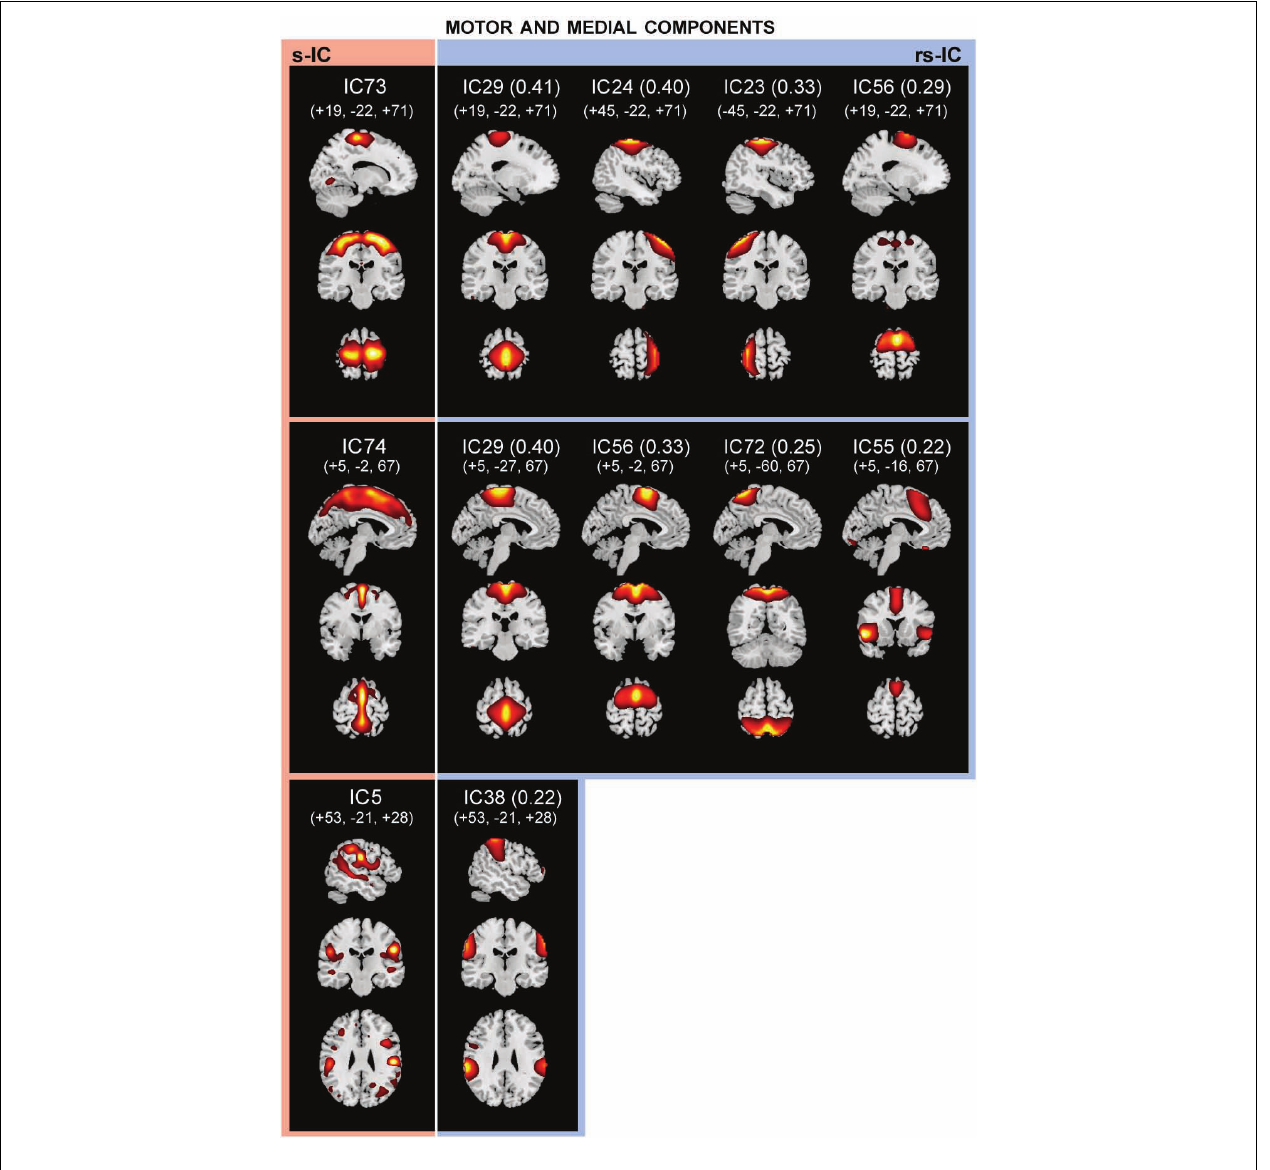
peak activation, indicated as ( x , y , z ) coordinates in MNI space.When structural components are paired with a single functional component, the functional component is displayed at the same slices. If a structural component corresponds to several fMRI components, functional components may be displayed at different coordinates that best represent their